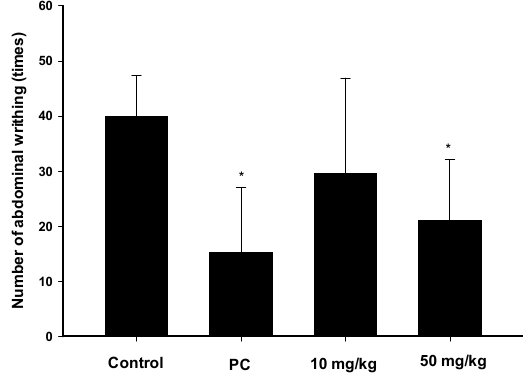
Figure 3. Abdominal writhing response of acetic-acid induces in mice. There were six mice per group. Results are expressed as Mean ± SEM. The positive control (PC) was morphine (5 mg/kg). * p < 0.05, compared to the control group.